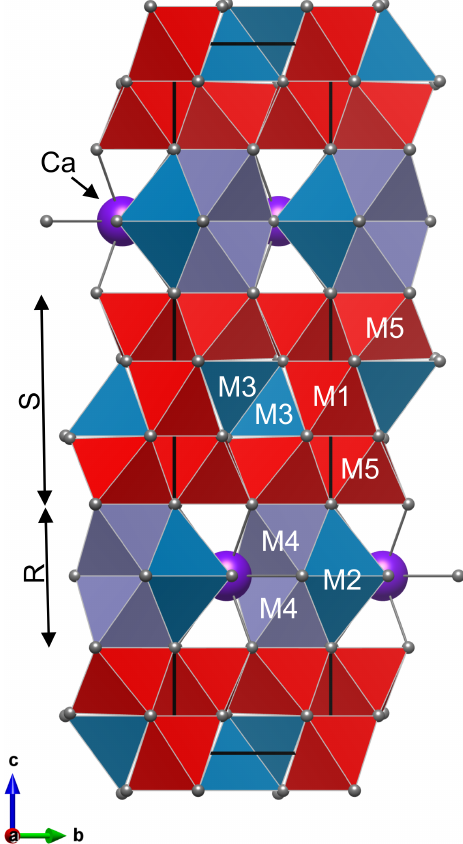
Figure 1. Structure of hibonite CaAl 10 Fe 2 O 19 with cation sites M1–M5: unit cell is made of two spinel blocks (S) and two conduct- ing blocks (R). Colours of polyhedra show occupancy of M sites: pure Al in red, (Al, Fe) polyhedra in teal, and (Al, Fe, Ti) octahedra in lilac.